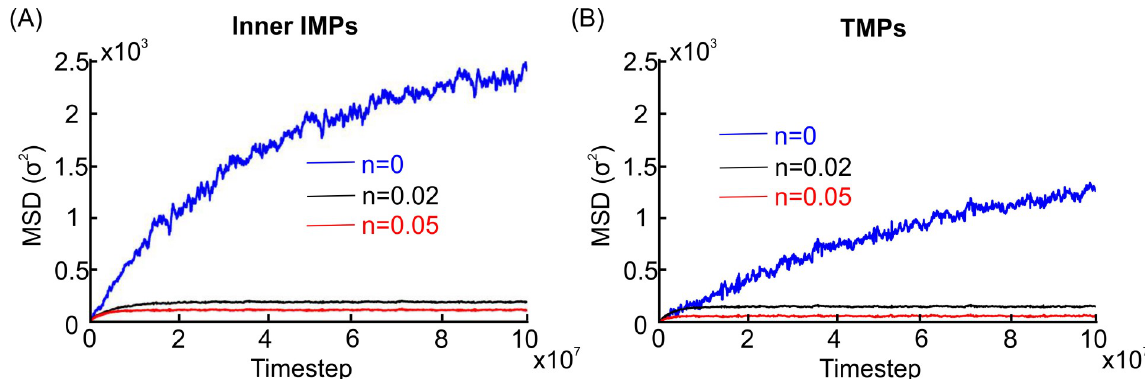
Fig 6. MSDs of the inner leaflet IMPs and TMPs along the axon’s circumferential direction. (A). Transverse MSD of the inner leaflet IMPs at different spectrin-lipid associations. (B). Transverse MSD of TMPs at different spectrin-lipid associations.